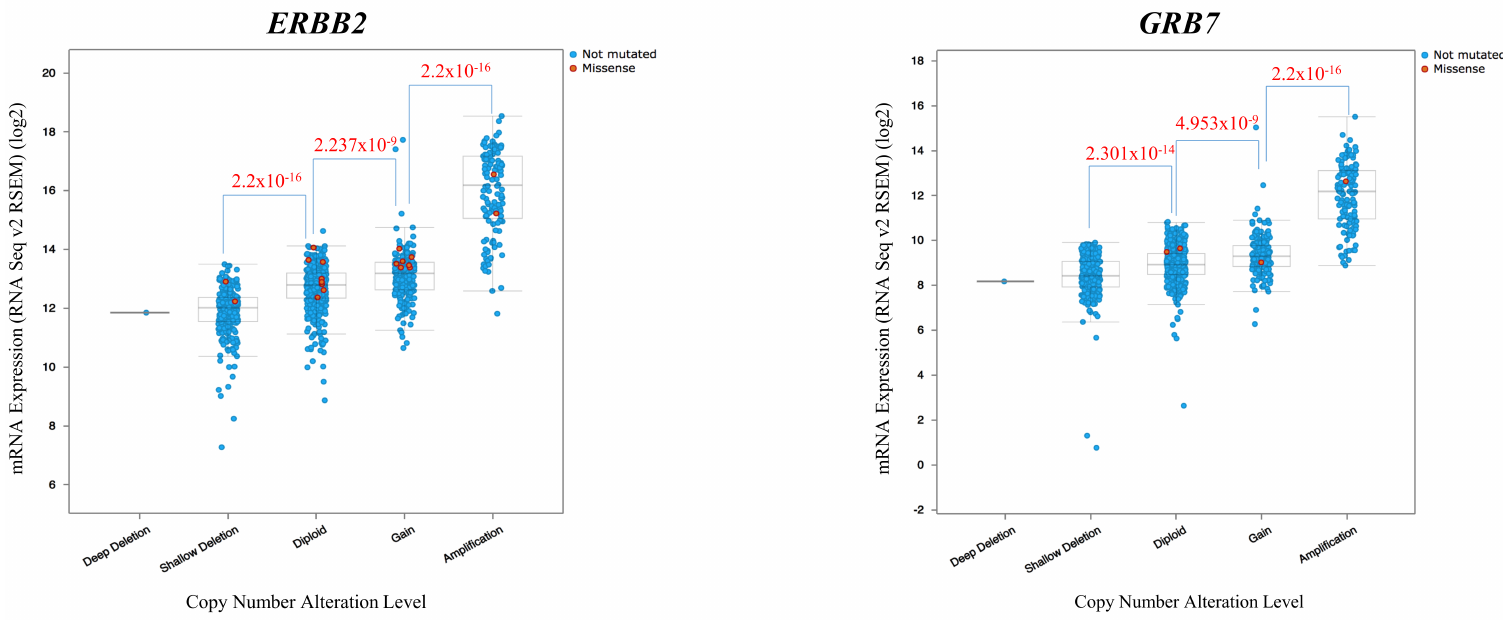
Figure 5. Relationships between copy number alteration and mRNA expression for ERBB2 and GRB7 in clinical breast invasive carcinoma samples. p -values were calculated by Wilcoxon rank sum test, except for only one breast carcinoma sample showing deep deletion of both ERBB2 and GRB7